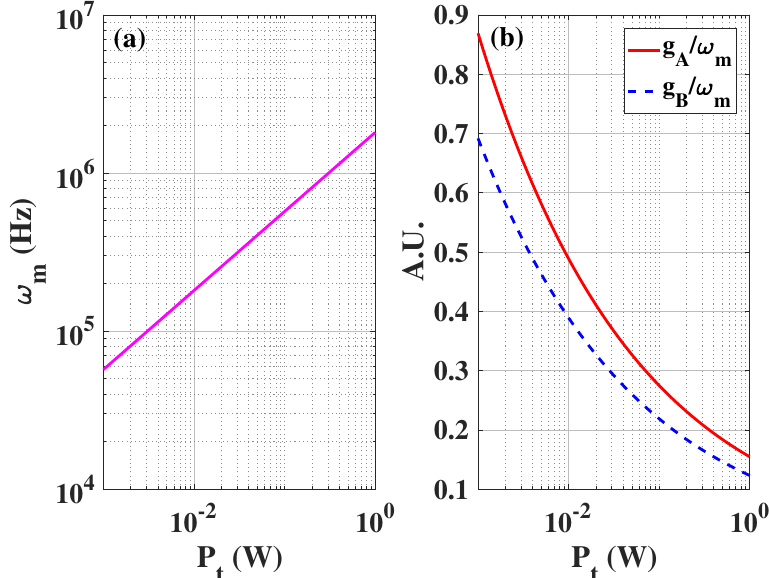
Figure 2. The torsional frequency ω m ( a ) and the ratio between the coherent scattering coupling and torsional frequency ( b ) as a function of the tweezers power P t . The parameters are given as follows: the cavity length L = 1 mm, the wavelength of the optical tweezers λ A = 780 nm = 1 µ m, the principle axes of the nano- ( λ B = 980 nm), the beam waist of the tweezers in focus w j 0 ellipsoid a = 2 b = 2 c = 100 nm, the relative permittivity of the nano-ellipsoid ε = 2.1, and the density of the nano-ellipsoid ρ = 2200 kg/m 3 . For convenience, the power of two optical tweezers are assumed to be the same P j = P t